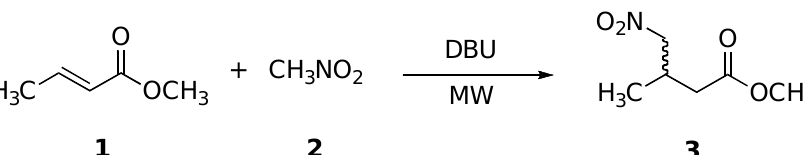
Table 1. Effect of DBU on the 1,4–addition of nitromethane ( 2 ) to methyl crotonate ( 1 ).